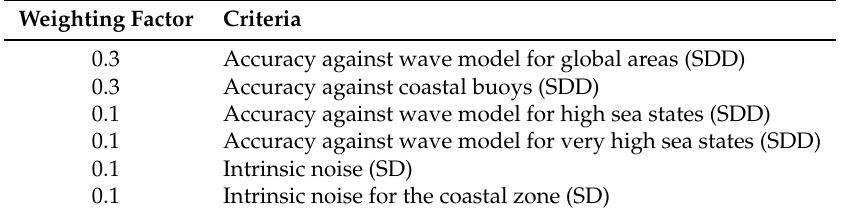
Table 5. Quantitative criteria for ranking the retracking algorithms.